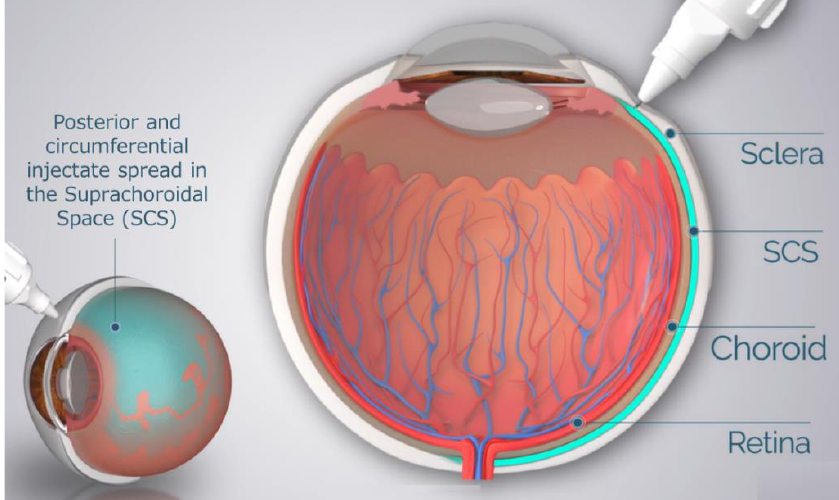
Figure 1. Schematic of Microneedle Injection into the Suprachoroidal Space (SCS). Drug delivery into the SCS has been achieved in multiple ways, in addition to the microneedle method, the predominate access technique clinically utilized. Small case